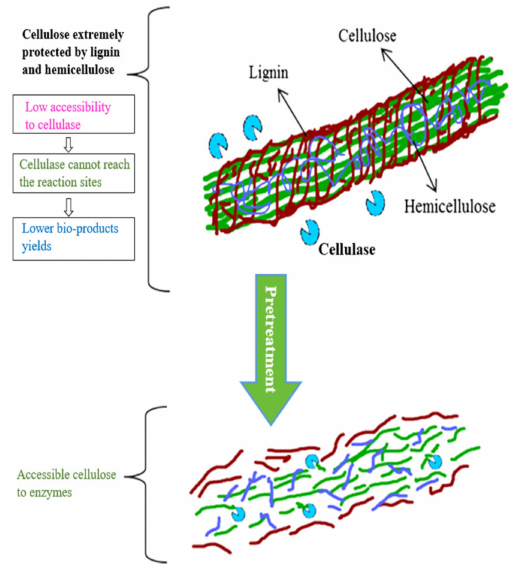
Figure 1. Schematic role for the pretreatments of interest. “Reprinted with permission from [33]. 2018,